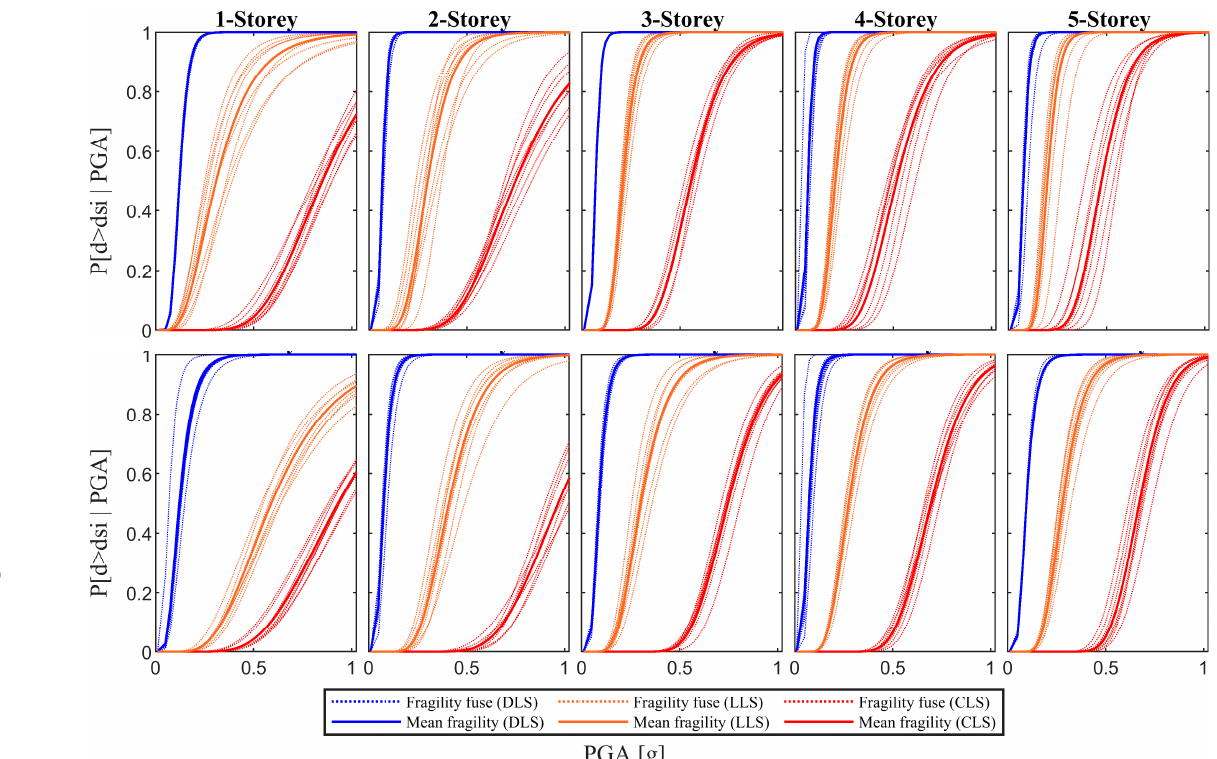
Figure 7. Resulting fragility curves for soil B; ( a ) Old; and ( b ) New.